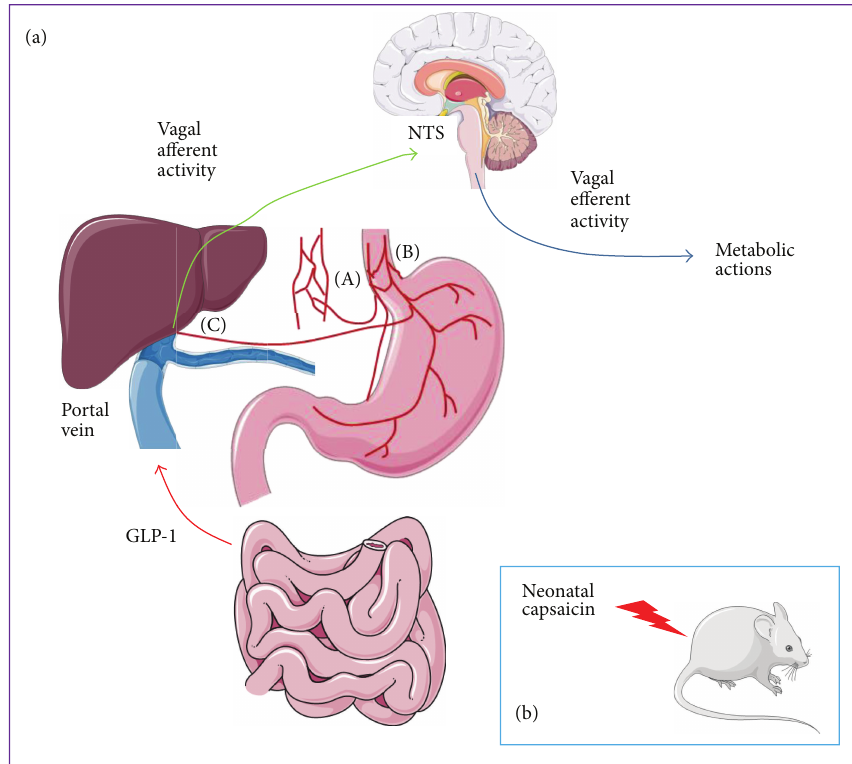
Figure 1: Evidence that physiological metabolic actions of GLP-1 are dependent on integrity of vagal nerve. (a) Stimulation of the celiac branch of the subdiaphragmatic vagus nerve (A) significantly stimulated the secretion of GLP-1 [44]. Enhancement of insulin secretion and reduction of glucagon secretion during OGTT by DPP-IV inhibitor or by GLP-1 analogs were reduced in vagotomized subjects (B) [45, 46]. GLP-1 is secreted during meal by the gut and partly reached the portal vein. Chemical destruction of the afferent fibers of the periportal vagus nerve including the hepatoportal sensor (C) limits the effects of portal GLP-1 on glucose metabolism [50]. Administration of physiological doses of GLP-1 into the portal vein modified the electrical activity of vagus nerve fibers [51] and portal perfusion of low doses of an antagonist of GLP-1 caused hyperglycemia during the concomitant oral administration of glucose [52]. (b) In mice denervated at birth by the injection of capsaicin, incretin effect was lost [43]. NTS: nucleus tractus solitarius. Pictures of organs and mice from Servier Medical